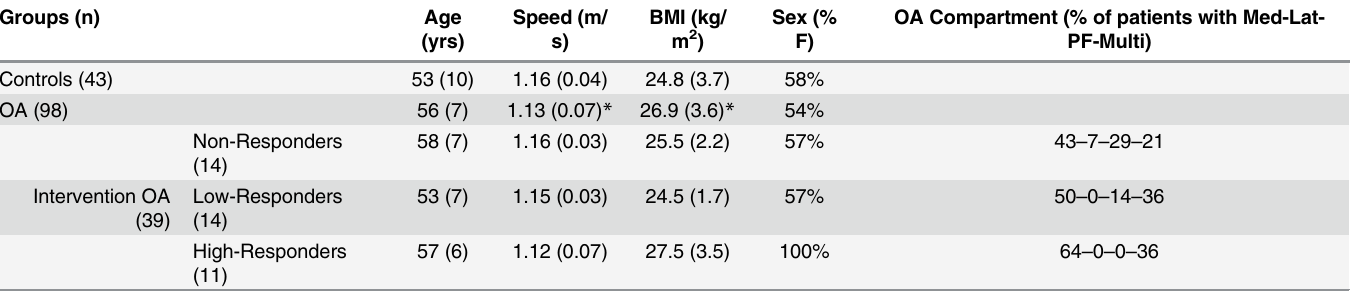
* OA signi fi cantly different from Controls (p <